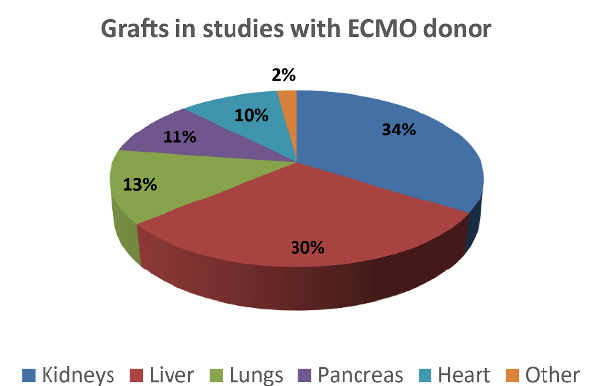
Figure 3. Classification of the identified studies by considering the organ.